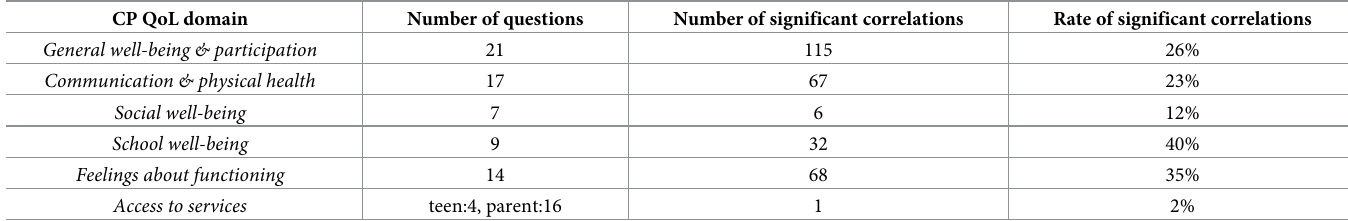
Table 2. Differences between adolescents’ and parents’ domains in Hungary.